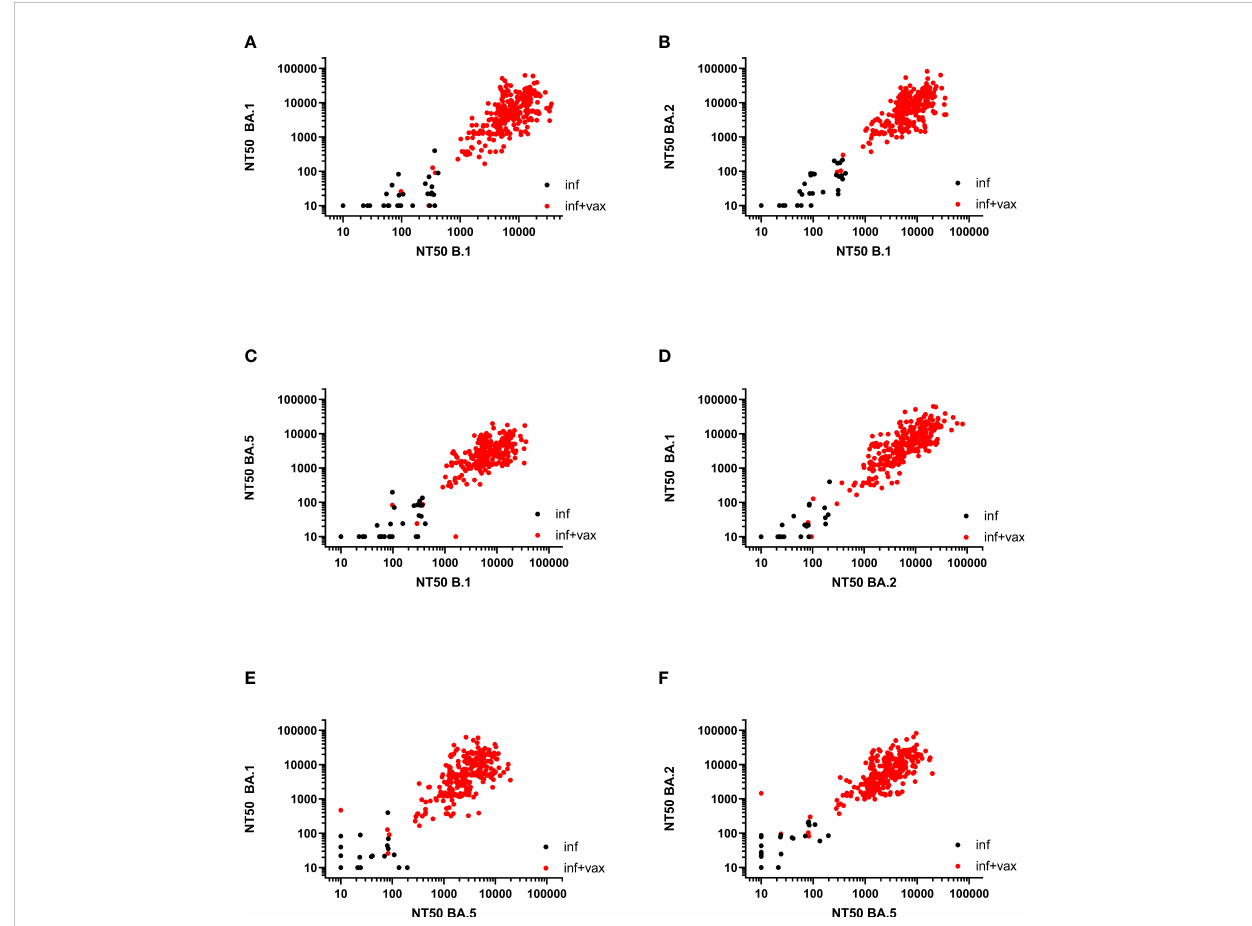
FIGURE 4 Correlation between NT50 values of SARS-CoV-2 variants. (A) Correlation between NT50 against BA.1 and NT50 against B.1 (Spearman correlation 0.72). (B) Correlation between NT50 against BA.2 and NT50 against B.1 (Spearman correlation 0.73). (C) Correlation between NT50 against BA.5 and NT50 against B.1 (Spearman correlation 0.66). (D) Correlation between NT50 against BA.1 and NT50 against BA.2 (Spearman correlation 0.84). (E) Correlation between NT50 against BA.1 and NT50 against BA.5 (Spearman correlation 0.71). (F) Correlation between NT50 against BA.2 and NT50 against BA.5 (Spearman correlation